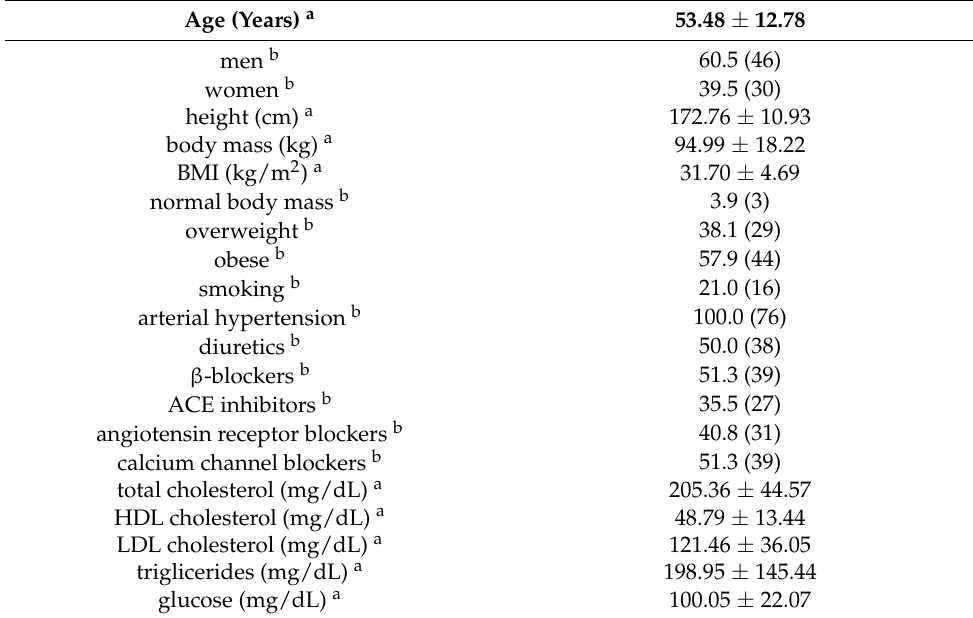
Table 1. Clinical characteristics of the studied group of